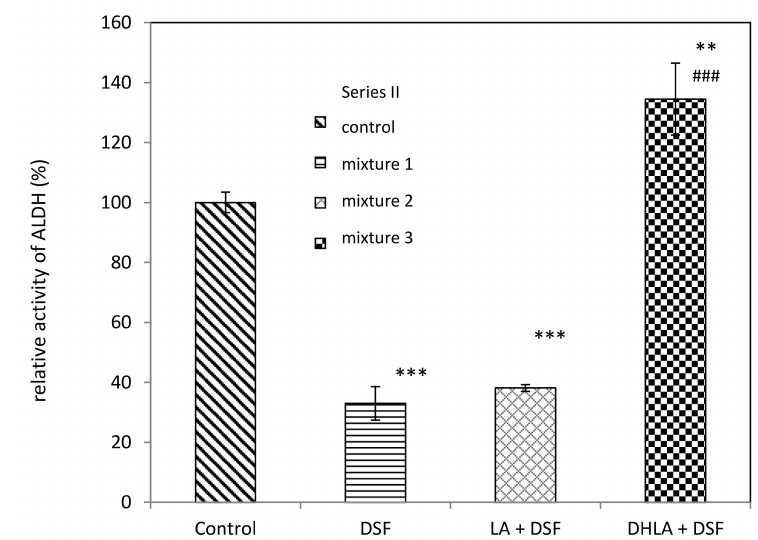
Figure 2. DHLA was able to protect ALDH against the inhibitory e ff ect of DSF. The ALDH activity was assayed with propionaldehyde (8 µ M) as a substrate by measuring the reduction of NAD (1 mM) at 340 nm. Data are presented as a percentage relative to the control (100%) (without DSF, LA, and DHLA). Three independent experiments were performed, each in triplicate. Data are shown as the mean ± SD. Significant vs. control sample: ** p < 0.01, *** p < 0.001. Significant vs. DSF sample: ### p < 0.001.